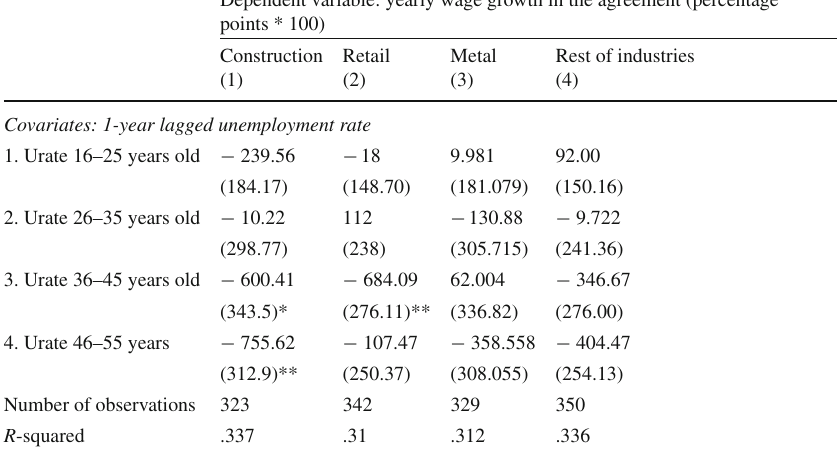
Table 3 The determinants of wage growth in collective agreements: lagged unemployment rate Dependent variable: yearly wage growth in the agreement (percentage points *